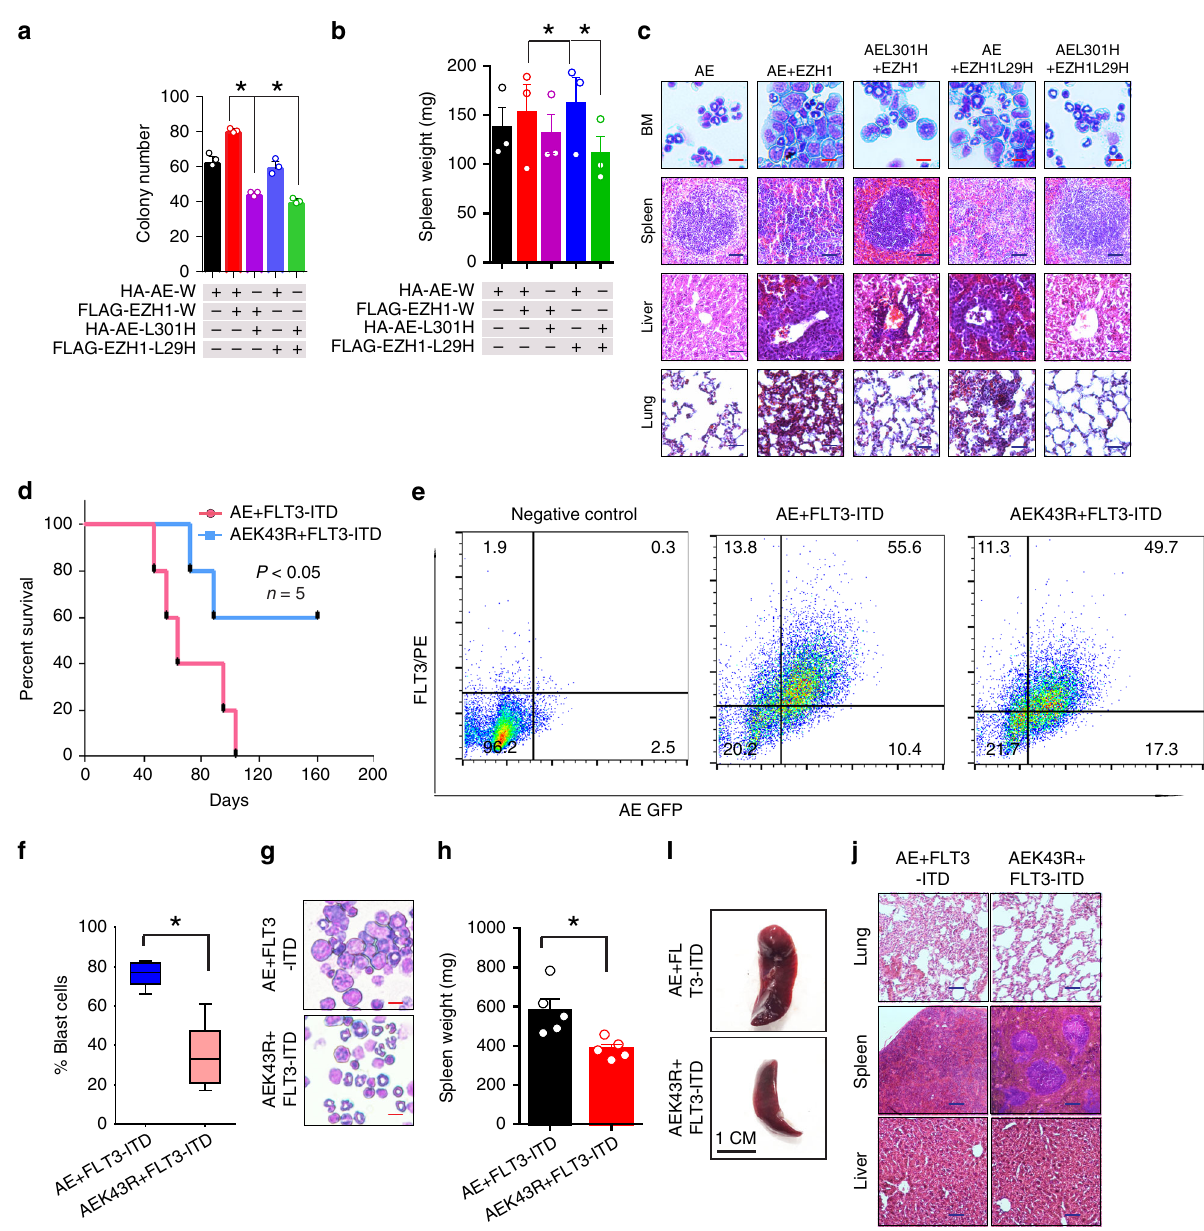
Fig. 6 EZH1-mediated Lys43 methylation is essential for leukemic cell expansion. a Colony-forming assays in C1498 cells transfected with HA-AE-W (wild type) and FLAG-EZH1-W or the indicated mutant constructs ( n = 3). b Graph illustrates the average of the spleen weights from leukemic mice ( n = 3 mice/group) engrafted with C1498-transfected cells (0.1 × 10 6 , from a ). c Wright/Giemsa staining of BM and H&E staining of sections from the spleens, lungs, and livers of leukemic mice engrafted with the transfected C1498 cells (from a ). Scale bars represent 50 µ m (red) and 100 µ m (blue). d Kaplan – Meier survival curves of the engrafted mice. The mice transplanted with bone marrow cells co-expressing AML1-ETO plus FLT3-ITD developed fatal leukemia ( n = 5). e BM cells transduced with AML1-ETO plus FLT3-ITD or AML1-ETOK43R plus FLT3-ITD viruses were injected into C57BL/6 J mice ( n = 5 mice/group) through the tail vein. FACS analysis of the engrafted recipient BM cells from the representative disease mice. f , g Blast cell percentage by immunophenotype analysis ( f ) and morphological analysis ( g ) of hematopoietic cells in bone marrow from the representative disease mice (from d and e ). Scale bars represent 50 µ m (red). h Graph illustrates the average of the spleen weights (from d and e ) ( n = 5). i Representative external views of the spleens from the leukemic mice (from d and e ). j H&E staining of sections from the spleens, lungs, and livers of the leukemic mice (from d and e ). Note, Fig. a , data are expressed as mean values ± S.E.M. of triplicate samples from three independent experiments; Fig. b , h , graphs are the average of spleen weight and data are expressed as mean values ± S.D; Fig. j , original magni fi cation ×200 and scale bars represent 100 µ m (blue); BM bone marrow, AE AML1-ETO; * P < 0.05; Fig. a , b , f , h , one-way ANOVA; d , Log-rank test; For box-whisker plots, box edges correspond to 25th and 75th percentiles, lines inside the box correspond to 50th percentiles, and whiskers include extreme data points. Source data are provided as a Source Data fi